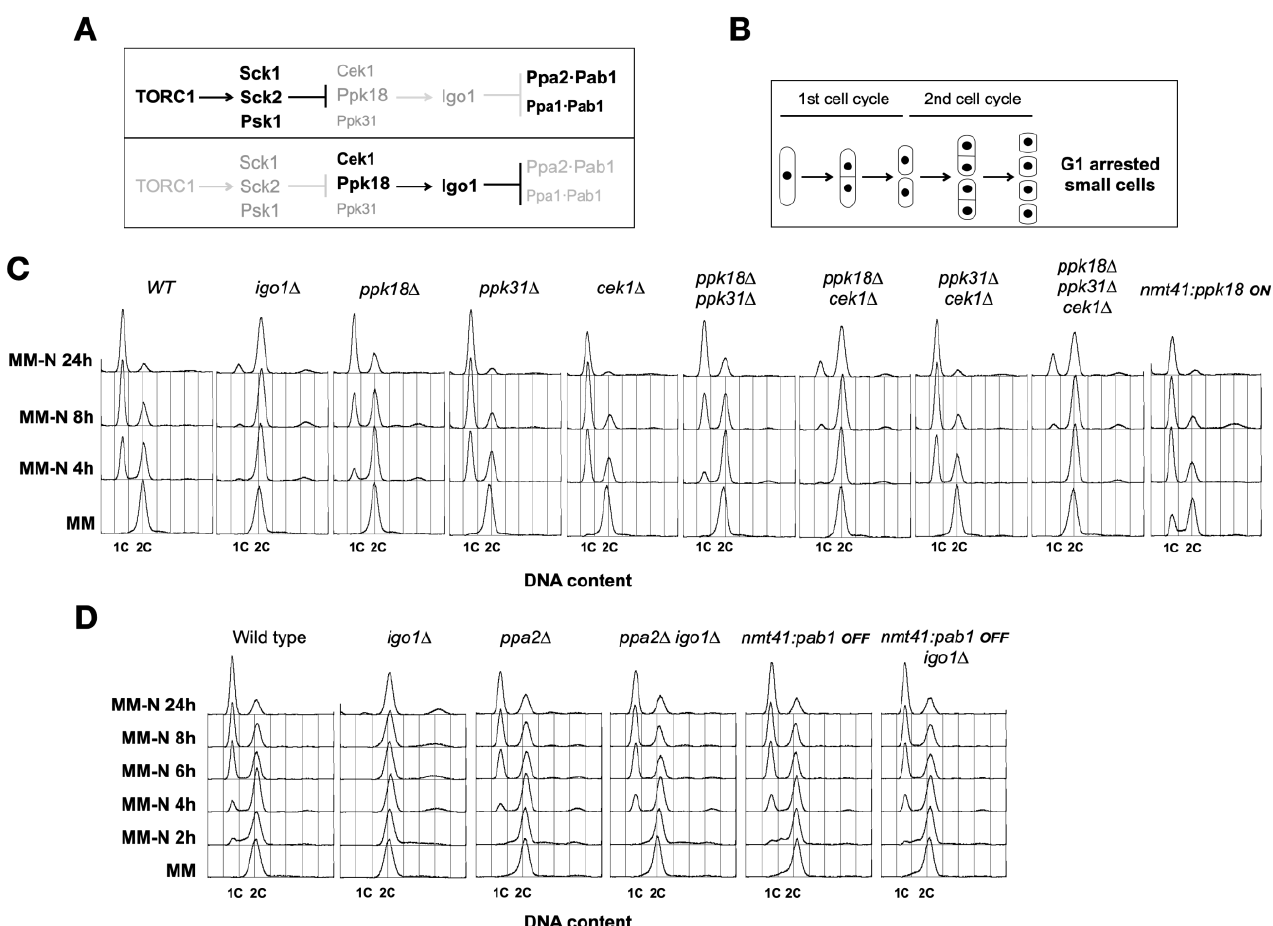
Figure 1. The Greatwall – Endosulfine switch is required for the last two cell divisions preceding G1 arrest in nitrogen-free medium (MM-N). ( A ) Schematic of the Greatwall – Endosulfine – PP2A/B55 pathway in fission yeast in nitrogen-rich media (above) and nitrogen-poor media (below). ( B ) Dia- gram of the two cell divisions that take place during nitrogen starvation. ( C ) FACS profile showing DNA content (1C and 2C) of wild type, igo1 ∆ , ppk18 ∆ , ppk31 ∆ , cek1 ∆ , ppk18 ∆ ppk31 ∆ , ppk18 ∆ cek1 ∆ , ppk31 ∆ cek1 ∆ , ppk18 ∆ ppk31 ∆ cek1 ∆ , and nmt41:ppk18 + cells grown in minimal medium (MM) at 25 ºC until mid-exponential phase and then transferred to MM-N. ( D ) FACS profile showing DNA content (1C and 2C) of wild type, igo1 ∆ , ppa2 ∆ , ppa2 ∆ igo1 ∆ , nmt41:pab1 + , and nmt41:pab1 + igo1 ∆ cells grown in MM containing thiamine (promoter OFF) at 25 ºC until mid-exponential phase and then transferred to MM-N.